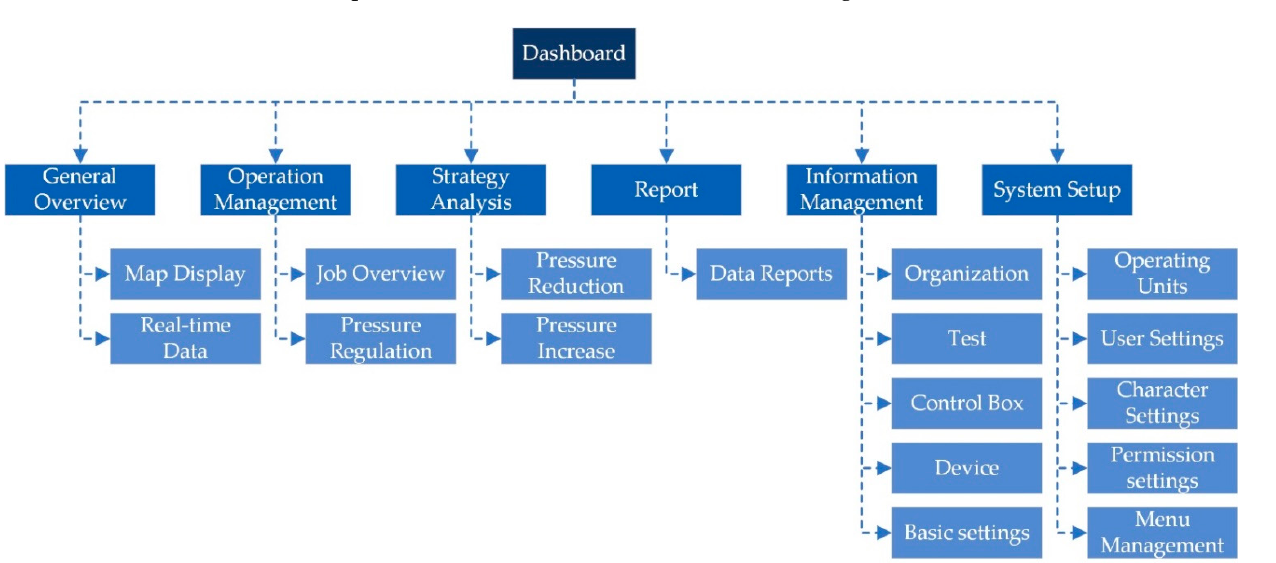
Figure A2. Management system deployment of IPRV.